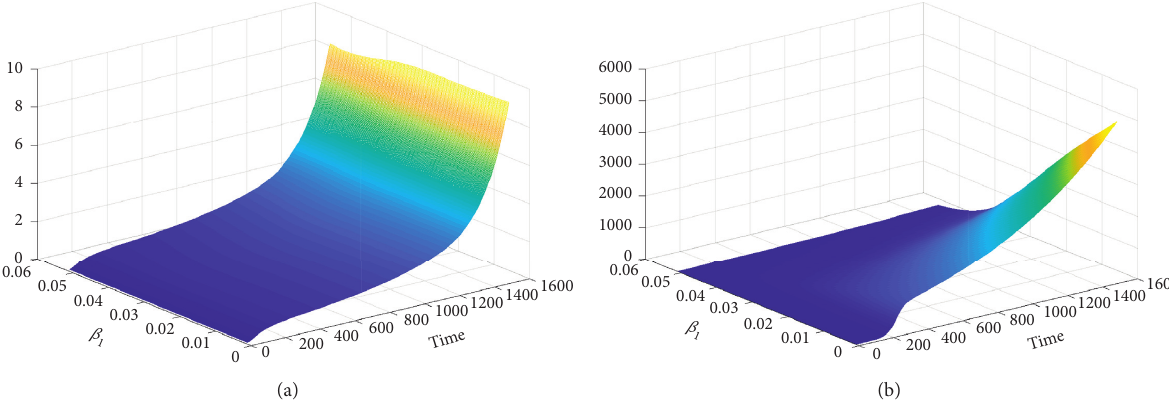
Figure 8: Amount of the information as a function of time and β controls.